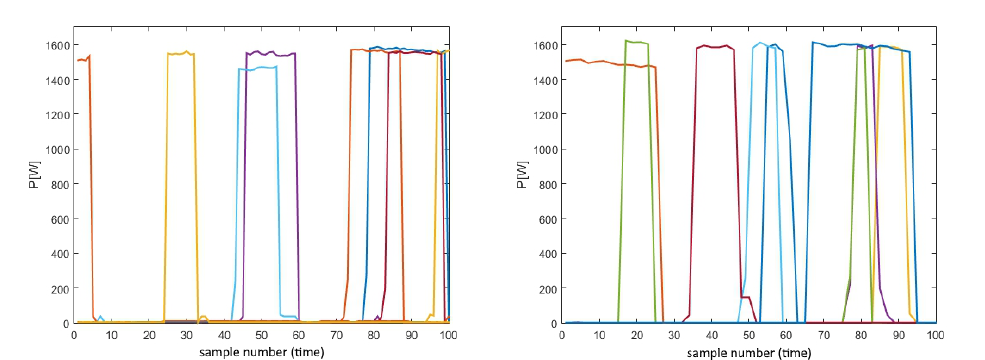
Figure 8. REDD’s (1) and UK-DALE’s (2) examples of microwave power consumption.